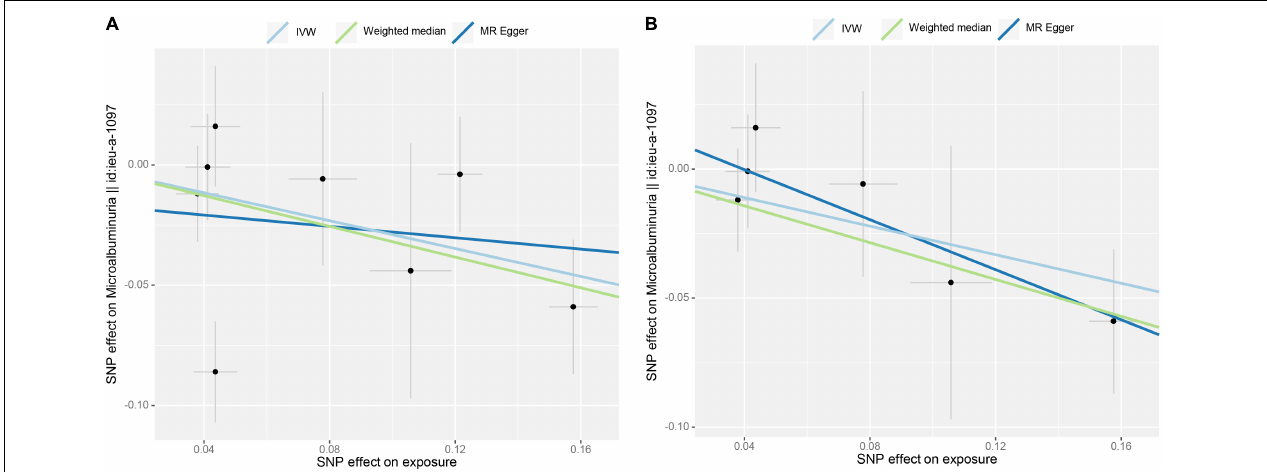
FIGURE 4 | Scatter plot of the effect size for each SNP on tea consumption and albuminuria. (A) No SNP was excluded. (B) Two SNPs were removed (rs1030510 and rs4410790) due to potential horizontal